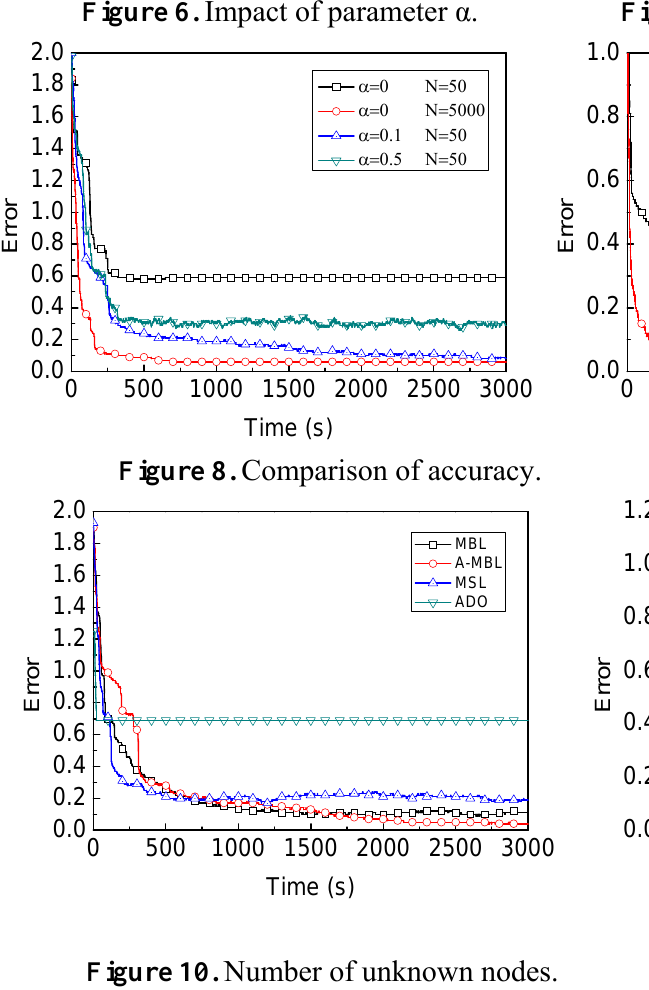
Figure 10. Number of unknown nodes. Figure 11. Impact of